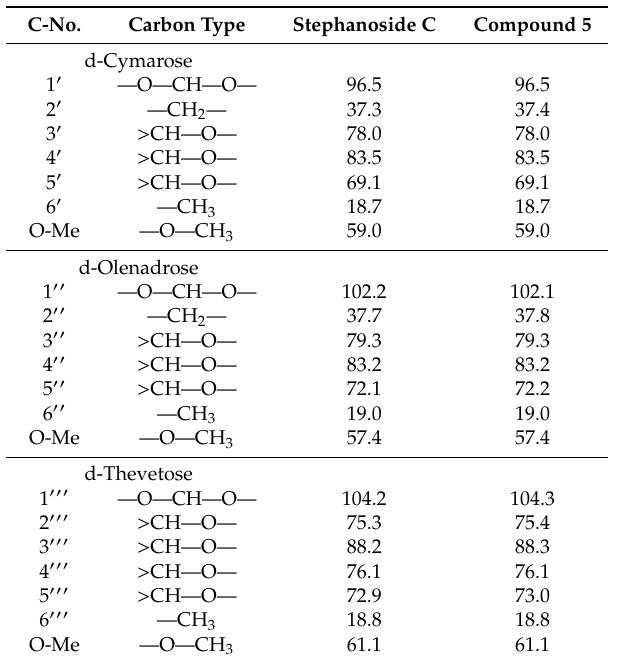
Table 4. The 13 C NMR chemical shifts of sugar chains of stephanoside C and compound 5 ( δ in ppm).